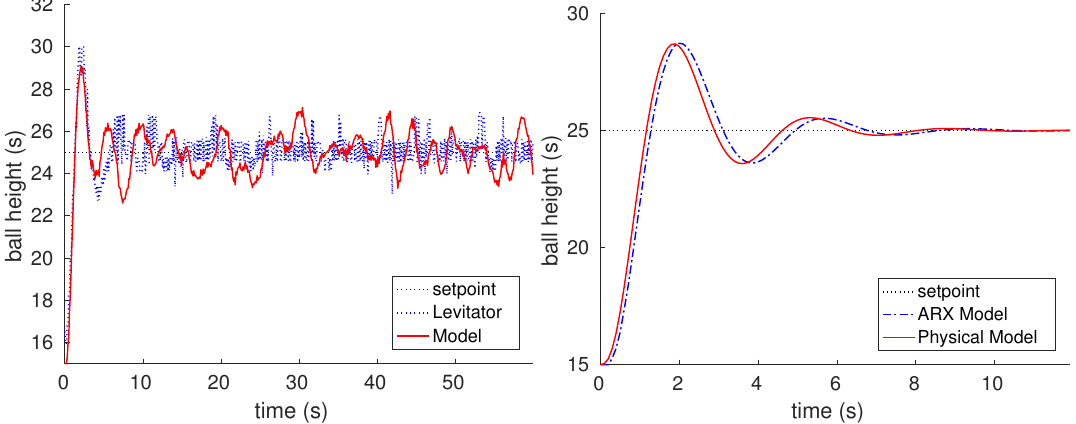
Figure A4. Compared response of the real (dotted line) and identified (solid line) process to a step input of amplitude 10 cm at the